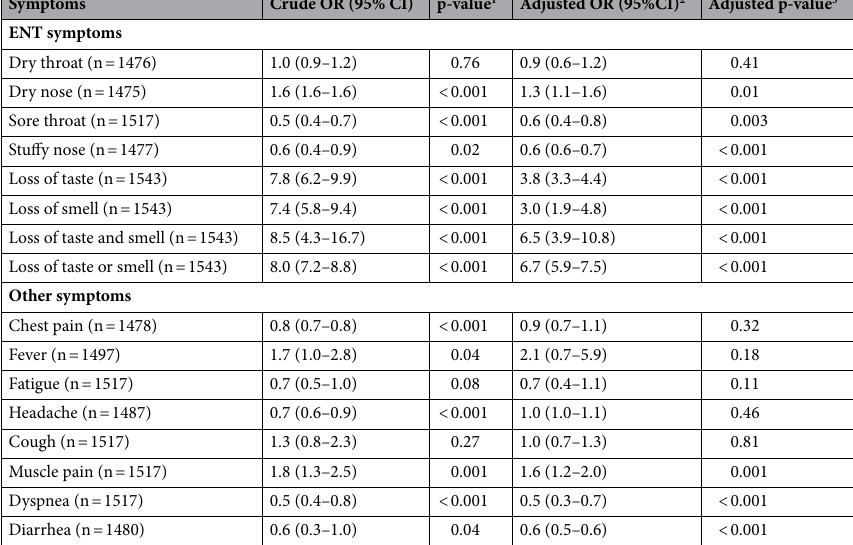
Table 3. Association between commonly reported symptoms, and positivity of the SARS-CoV-2 RT-PCR test (unadjusted and adjusted analysis). 1 Univariate logistic regression (adjusted for clustering within labs). 2 Number of available data: 1194. 3 Multivariable logistic regression (adjusted for clustering within labs, gender,